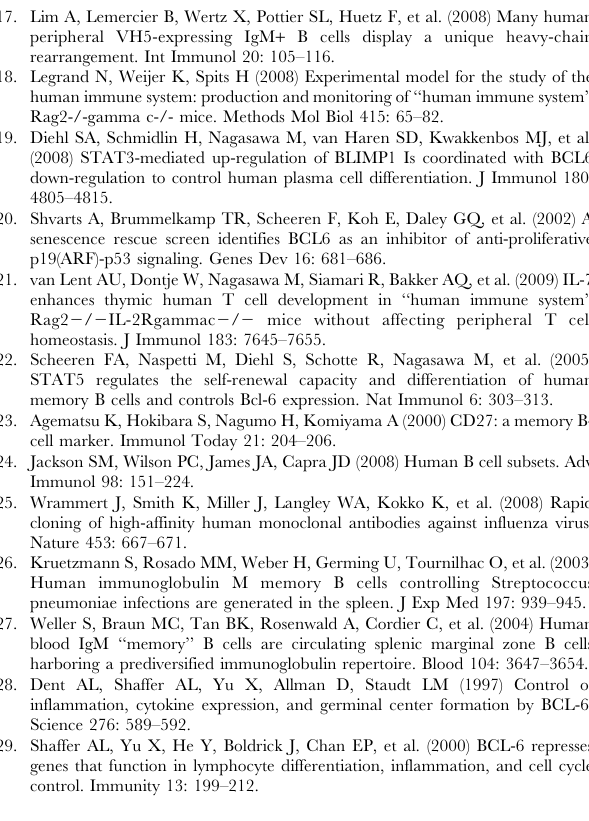
Figure S1 IgG/IgA B cell repertoire in naı¨ve HIS mice. Similarly to Figure 1E, the naive IgG (A) and IgA (B) B cell repertoires of HIS (BALB-Rag/ c ) mice were evaluated on splenocytes by performing a BCR immunoscope for each V H family. The profiles obtained with control human PBMC are also shown. Table S1 Human cell numbers measured in the BM of vaccinated HIS mice. Data from the TT and HBsAg vaccination experiments are pooled, and are presented as in the Table 2.